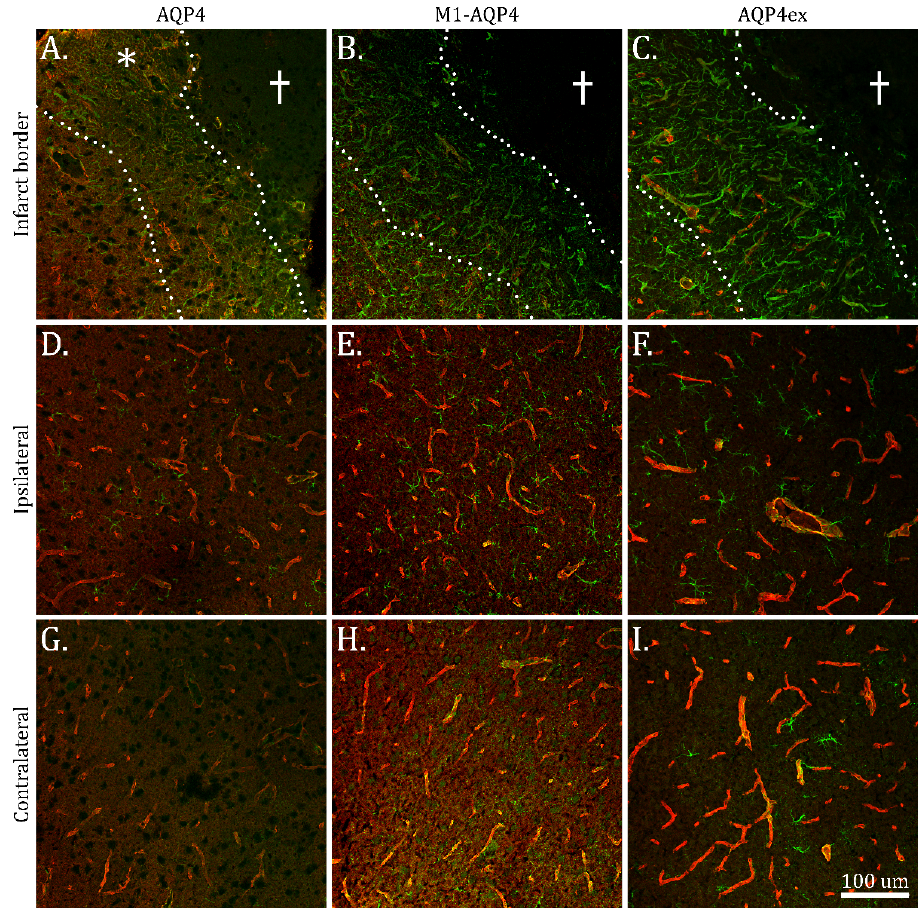
Figure 4. Loss of M1-AQP4 and AQP4ex in the infarct border zone. Confocal immunofluorescence images taken with 20 × objective. ( A–C ) Dotted lines indicate extent of incipient glial scar, the cross shows infarct core. ( A ) AQP4 loses its perivascular polarization in the inner half of the glial scar-forming zone. Pronounced AQP4 staining is present in areas not associated with the perivascular processes (asterisk). In the same location, M1-AQP4 ( B ) and AQP4ex ( C ) are much reduced. Moving outwards from the core, there is an increased expression of perivascular AQP4 (total), M1-AQP4 as well as AQP4ex. Normal AQP4 ( D ), M1-AQP4 ( E ) and AQP4ex ( F ) as well as increased GFAP in reactive astrocytes are seen in the ipsilateral cortex. Contralateral cortex ( F – I ) shows normal expression of total AQP4 and its isoforms, and a mild degree of astrogliosis judged by GFAP immunostaining. Pseudo-colors: Red: total AQP4 ( A , D , G ), M1-AQP4 ( B , E , H ) or AQP4ex ( C , F , I ), Green: GFAP. Scale bar 100 µm for all images.